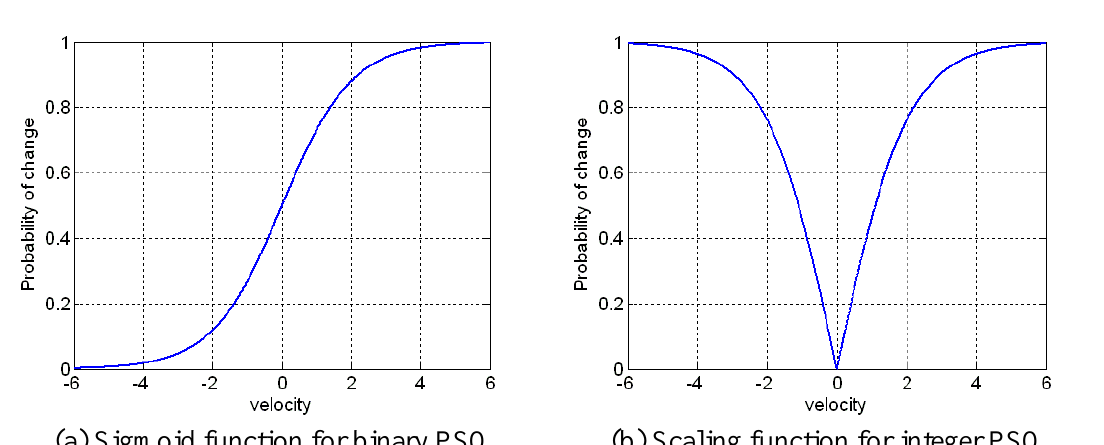
Figure 14. Scaling function of binary PSO based sigmoid function vs. integer PSO.